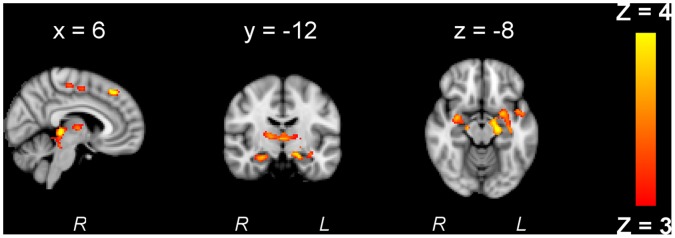
Performance related decrease of brain activity during and after stimulation.Activity decreased with time for contrast run1-run2 in the paracingulate gyrus, superior frontal gyrus, thalamus and hippocampus. (Z>3, P<0.05, corrected).